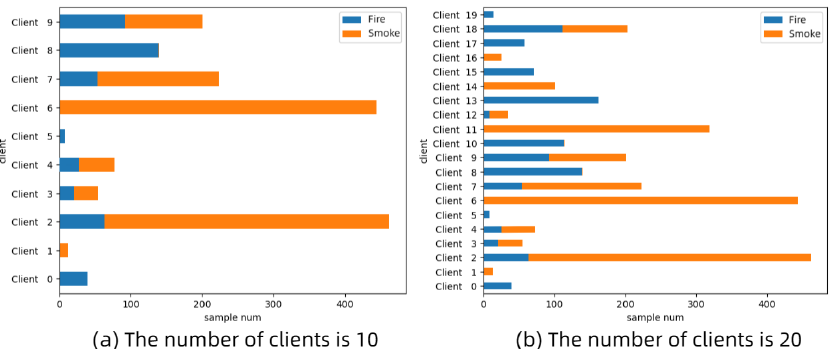
Figure 6. Data Partitioner in federated learning. The dataset used Internet downloaded images and collected public datasets to detect smoke and